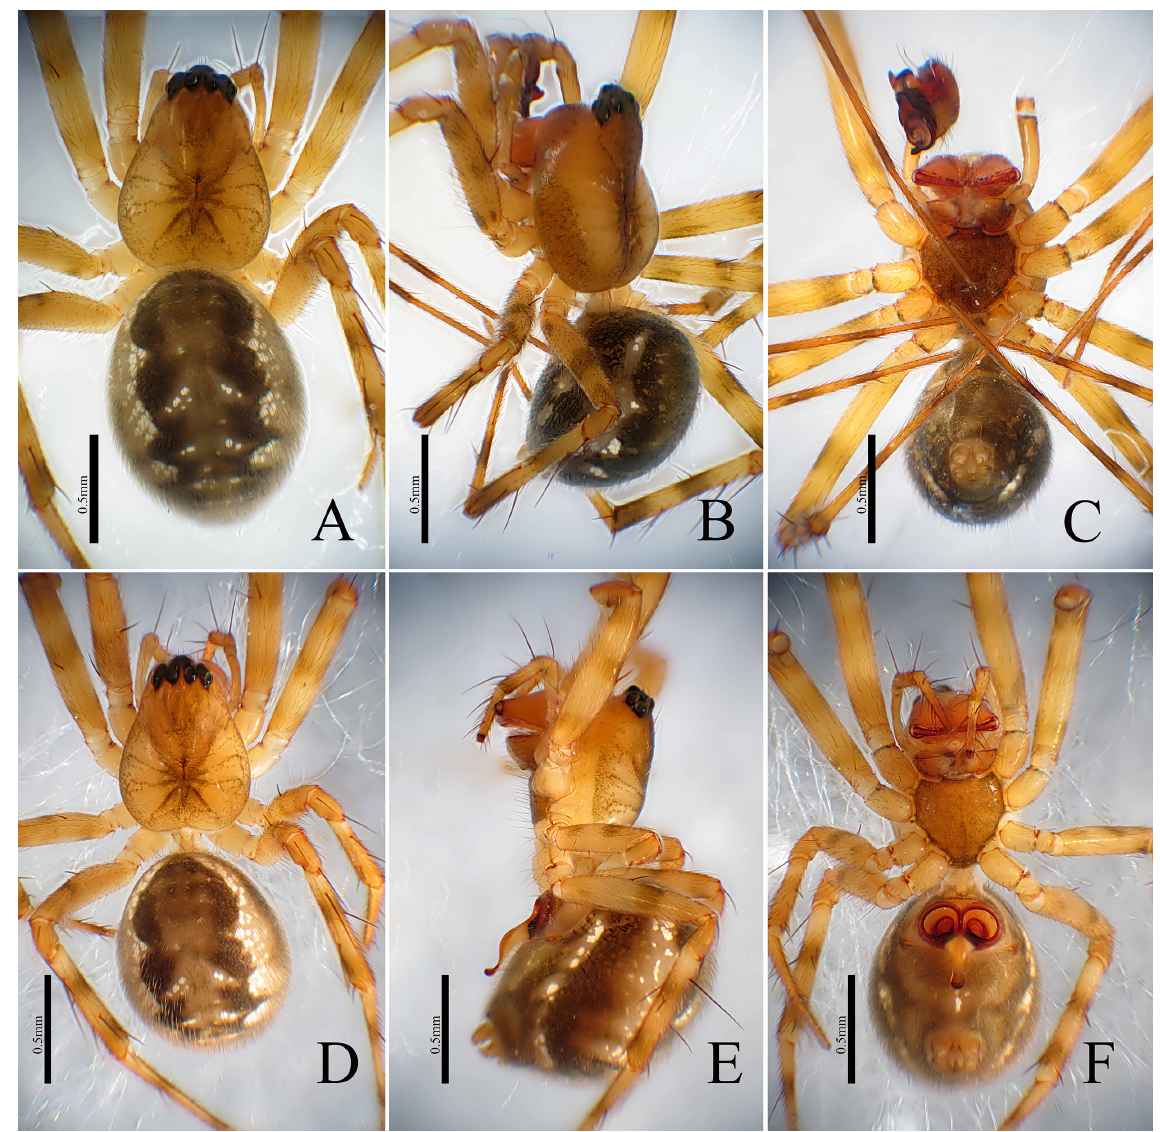
(HNU-CGY137). A , D . Habitus, dorsal view. B , E . Habitus, lateral view. C , F . Habitus, ventral